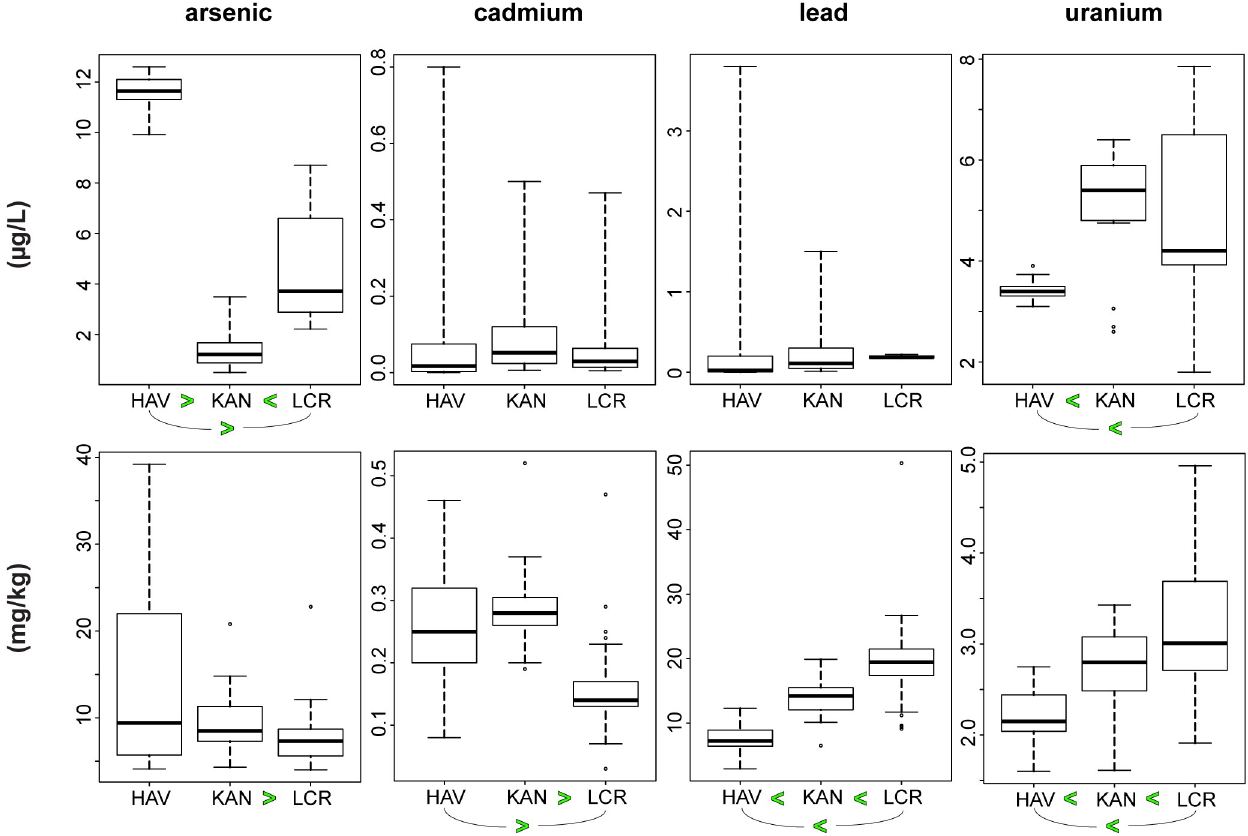
Fig 10. Boxplots showing the distribution of concentrations of arsenic, cadmium, lead, and uranium in water (top row) and suspended sediment (bottom row) at the Little Colorado River (LCR), Kanab Creek (KAN), and Havasu Creek (HAV) tributary sites. Less than ( < ) and greater than ( > ) symbols denote statistically significant differences between results from the